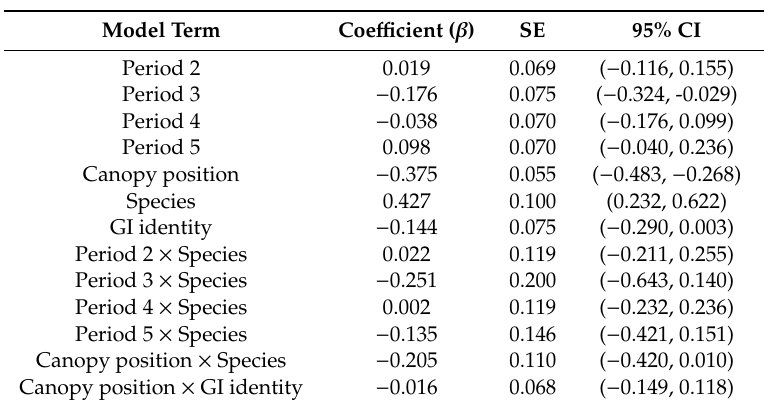
Table 3. Statistical modeling results for a linear mixed-e ff ects model of stomatal conductance. Bold depicts model terms with relatively strong influence ( ∆ AIC < 4 are c